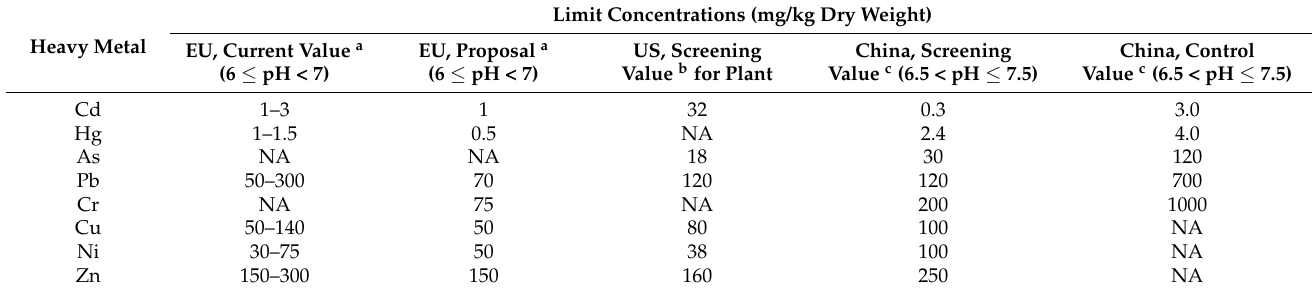
Table 5. Limit values for heavy metal concentration in agricultural soils. Limit Concentrations (mg/kg Dry